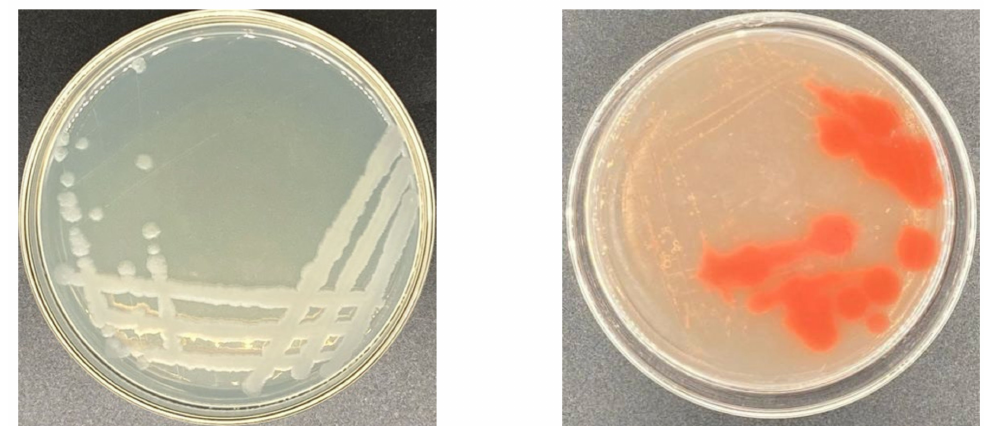
Figure 2. Growth of strain Y4 on Luria–Bertani (LB) agar plates and selenite containing plates. Images of cultures of strain Y4 grown in the absence ( left ) and presence ( right ) of 400 mM selenite. The red colony color indicates selenite reduction and the formation of elemental selenium (Se 0 ).